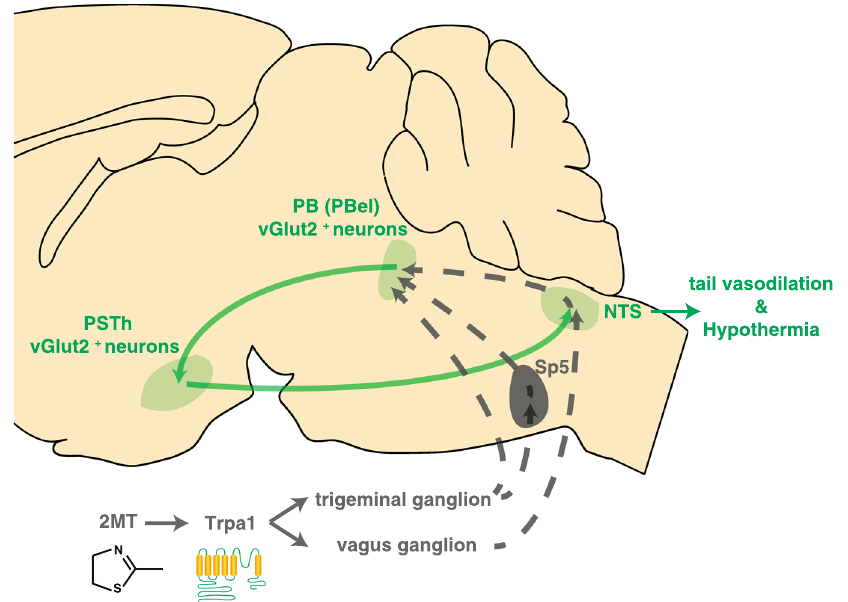
Fig. 8 Neural pathways for 2MT-evoked hypothermia. 2MT is sensed by Trpa1 in trigeminal ganglion (TG) neurons and vagal ganglion (VG) neurons. A subpopulation of vGlut2 + PBel neurons receive the 2MT signal directly from TG neurons or indirectly via Sp5 neurons. These vGlut2 + PBel neurons transmit the 2MT signal to vGlut2 + PSTh neurons, which relay the signal to NTS neurons to trigger hypothermia and tail